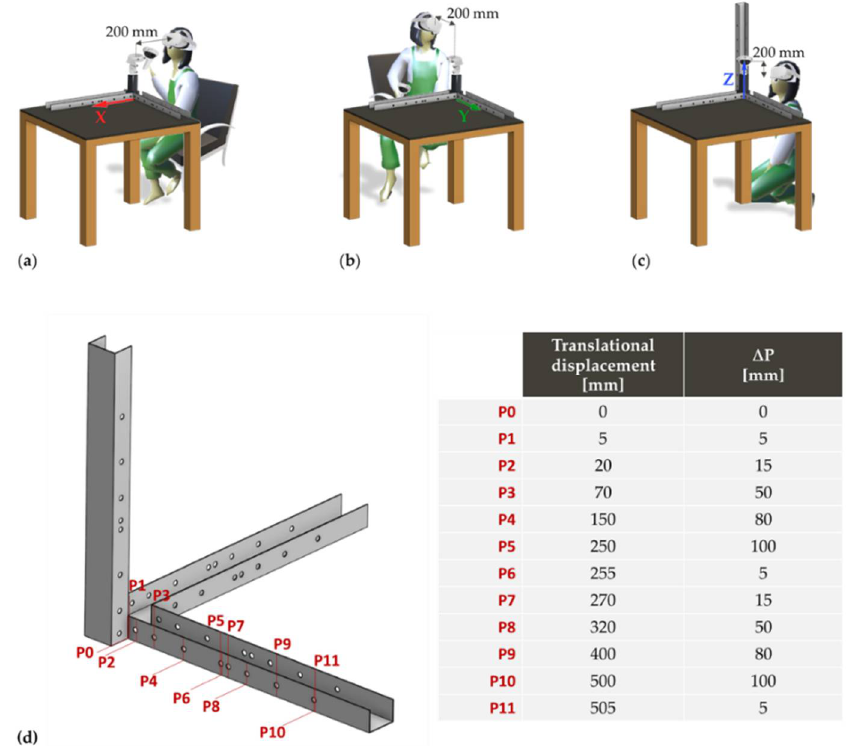
Figure 3. Acquisition configuration of translational displacements along the ( a ) x-axis, ( b ) y-axis, and ( c ) z-axis, starting at a distance of about 200 mm from the reference position P0; ( d ) representation of translational displacements P i (i = 1, . . . ,11) and variations ( ∆ P ), i.e., differences between translational displacements i th and i th − 1 .